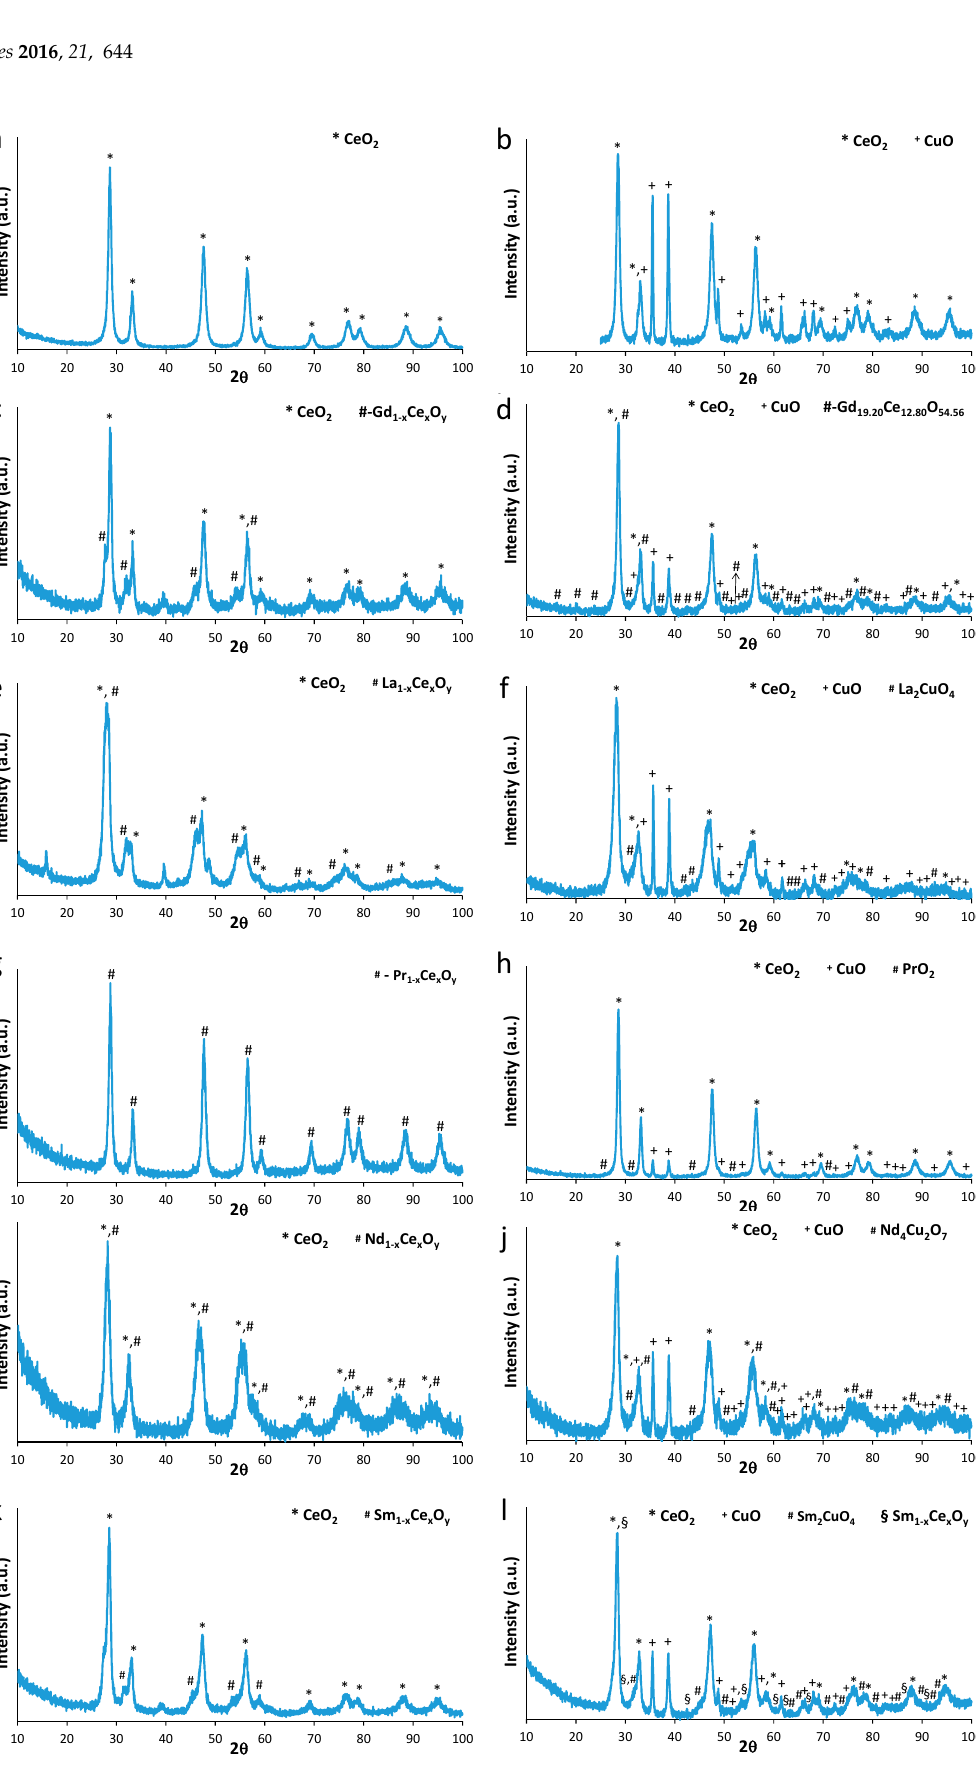
Figure 1. XRD patterns of CeO 2 ( a ); Cu/CeO 2 ( b ); Ce-Gd ( c ); Cu/Ce-Gd ( d ); Ce-La ( e ); Cu/Ce-La ( f ); Ce-Pr ( g ); Cu/Ce-Pr ( h ); Ce-Nd ( i ); Cu/Ce-Nd ( j ); Ce-Sm ( k ) and Cu/Ce-Sm ( l